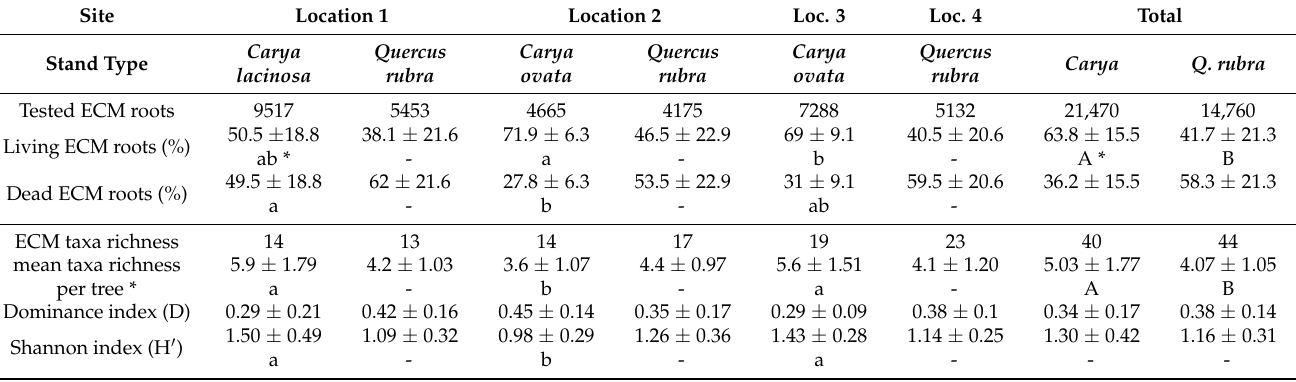
Table 2. Quantitative parameters of tested ectomycorrhizal roots and qualitative data of ECM fungal assemblages on Carya and Q. rubra roots (ECM taxa richness, diversity indices).